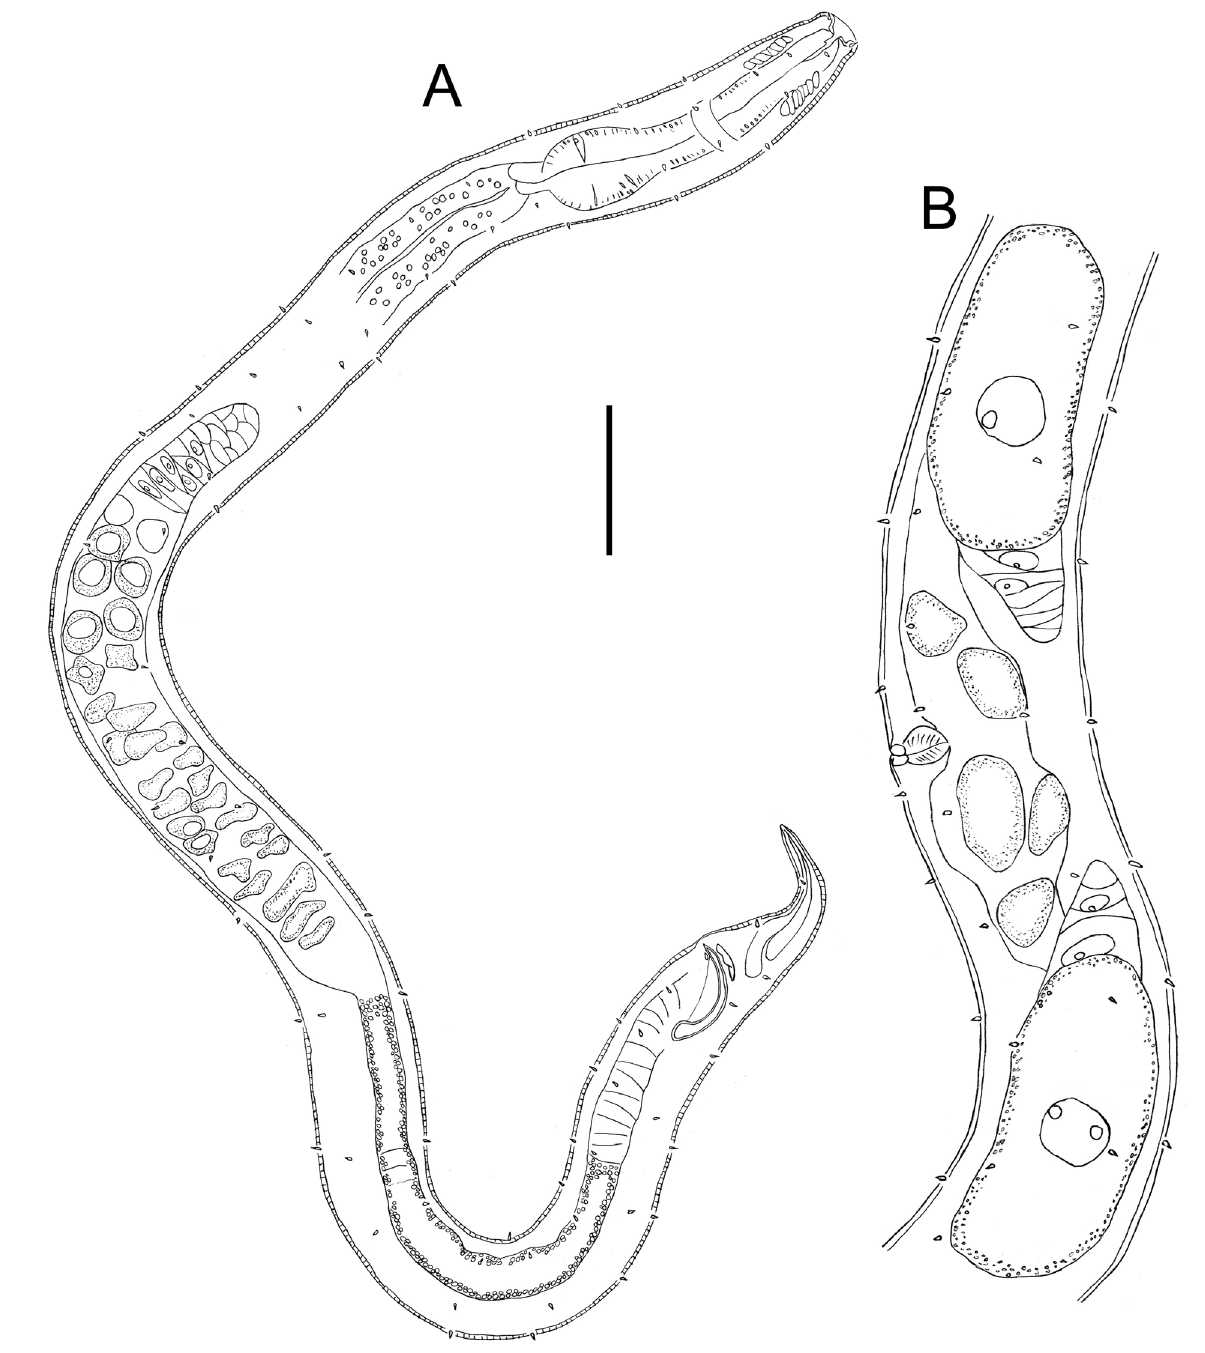
Fig. 2. Spirinia verecunda sp. nov. A . Entire male. B . Female reproductive system. Scale bar: A = 50 µ m, B = 30 µ